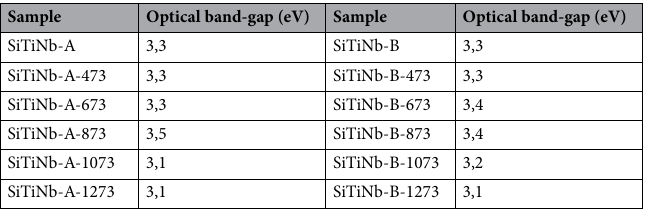
Table 6. Optical band-gap of SiTiNb-A and SiTiNb-B from the function of Kubelka–Munk.